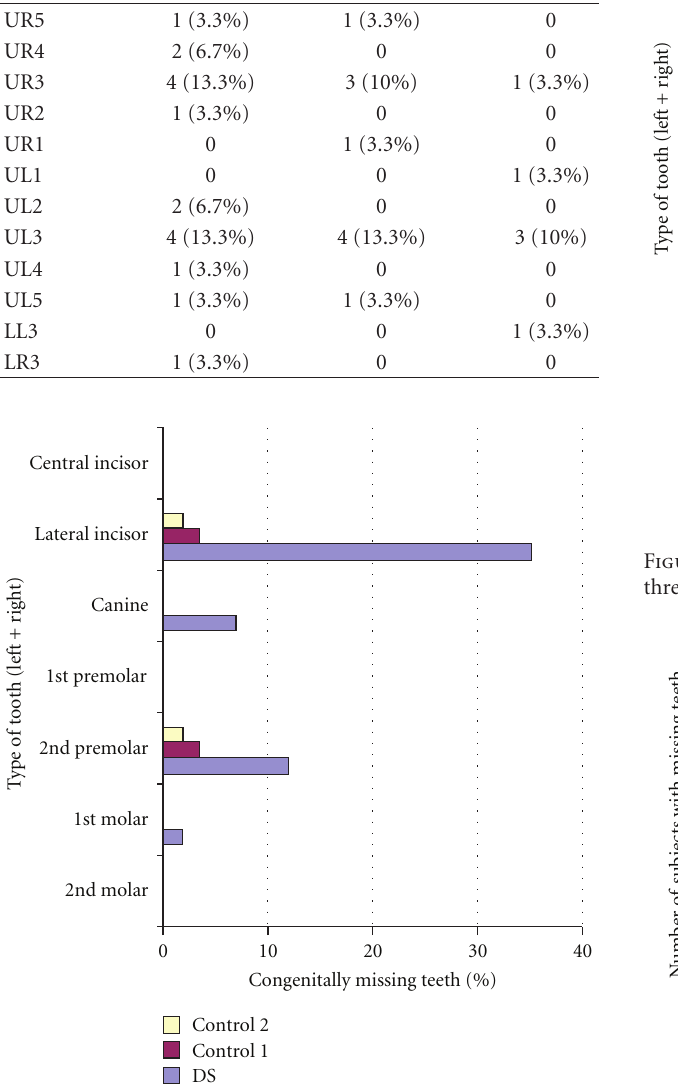
Table 5: Number and percentage of impacted teeth by group.